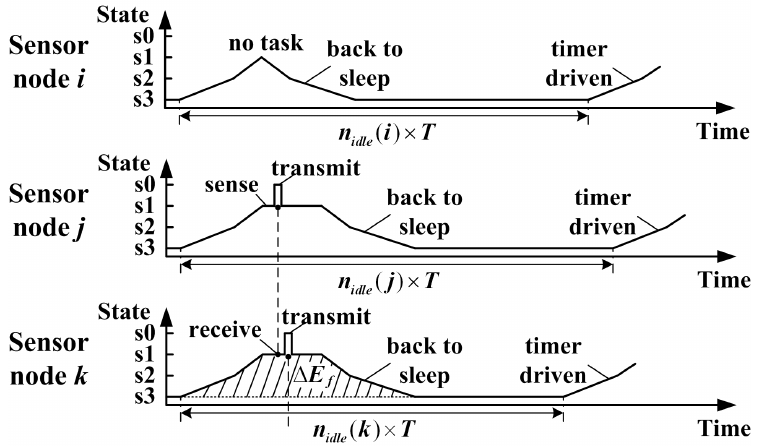
Figure 1. State transition of different sensor nodes with dynamic awakening